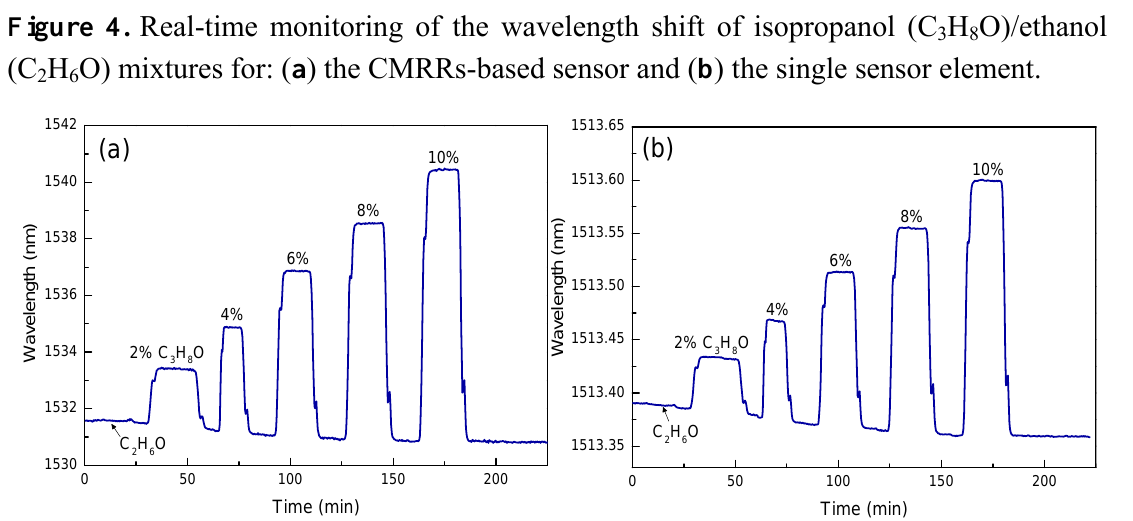
H O)/ethanol 3 8